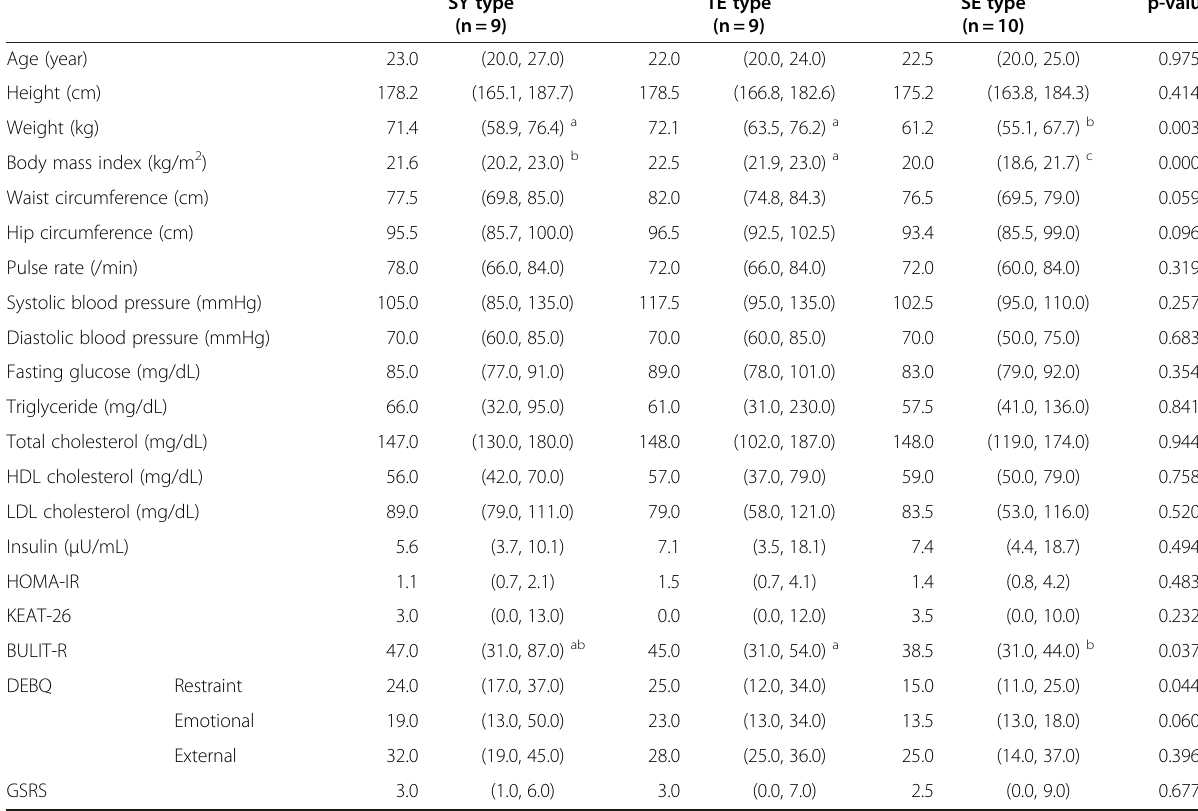
Table 3 Characteristics of participants in different Sasang constitutional groups SY type TE